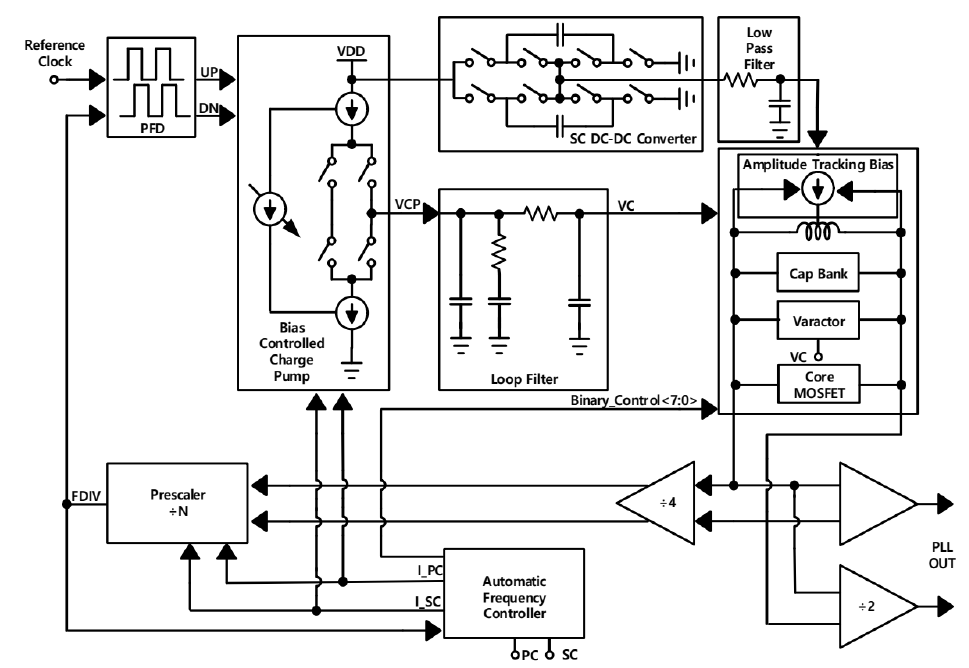
Figure 3. Proposed PLL block